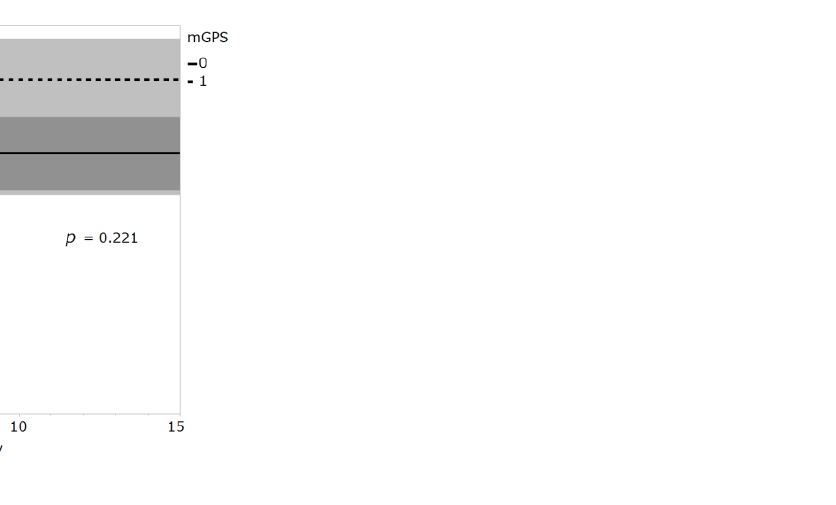
Figure 3. ( a ) Mann-Whitney U test comparing C-reactive protein with and without local recurrence. ( b ) Mann-Whitney U test comparing neutrophil count (×10 9 /L) with and without local recurrence. ( c ) Mann-Whitney U test comparing lymphocyte count (×10 9 /L) with and without local recurrence. ( d ) Mann-Whitney U test comparing monocyte count (×10 9 /L) with and without local recurrence. ( e ) Mann-Whitney U test comparing platelet count (×10 9 /L) with and without local recurrence. ( f ) Mann-Whitney U test comparing hemoglobin with and without local recurrence. ( g ) Mann-Whitney U test comparing alkaline phosphatase with and without local recurrence. ( h ) Mann-Whitney U test comparing lactate dehydrogenase with and without local recurrence. ( i ) Mann-Whitney U test com- paring neutrophil-lymphocyte ratio (NLR) with and without local recurrence. ( j ) Mann-Whitney U test comparing prognostic nutritional index (PNI) with and without local recurrence. ( k ) Mann- Whitney U test comparing lymphocyte-monocyte ratio (LMR) with and without local recurrence. ( l ) Mann-Whitney U test comparing platelet – lymphocyte ratio (PLR) with and without local recur- rence. ( m ) Local recurrence-free survival rates of patients by modified Glasgow prognostic score (mGPS). Shading around the curves represents the 95% confidence intervals (CIs).